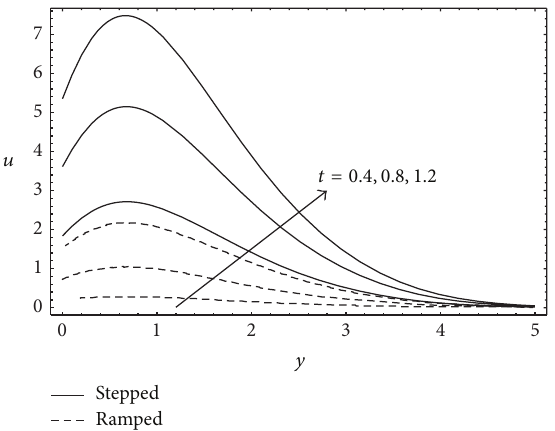
Figure 3: Velocity profiles for different values of 𝑡 with 𝜂 = 0.8 and Pr = 0.71